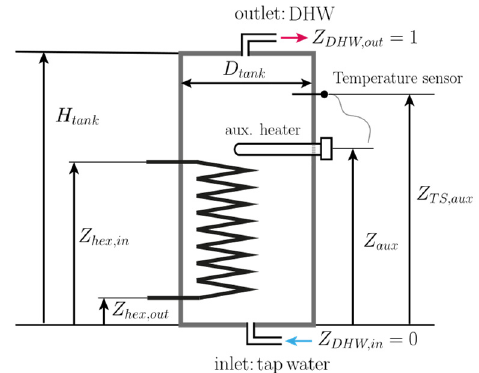
Figure 5. Schematic of the domestic hot water storage tank. Table 11. Geometrical features of the DHW tank.